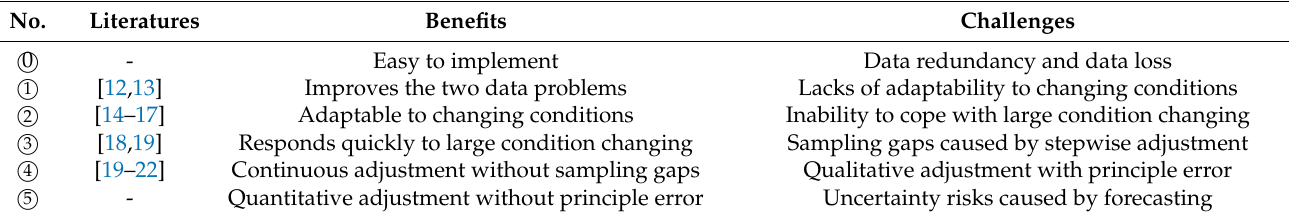
Table 1. Comparison table of different types of sampling strategies on segment